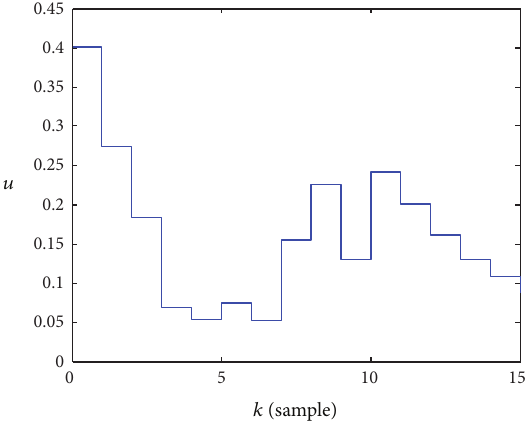
Figure 3: State feedback control law 𝑢(𝑘) = 𝐾 𝜎(𝑘) 𝑥(𝑘) .